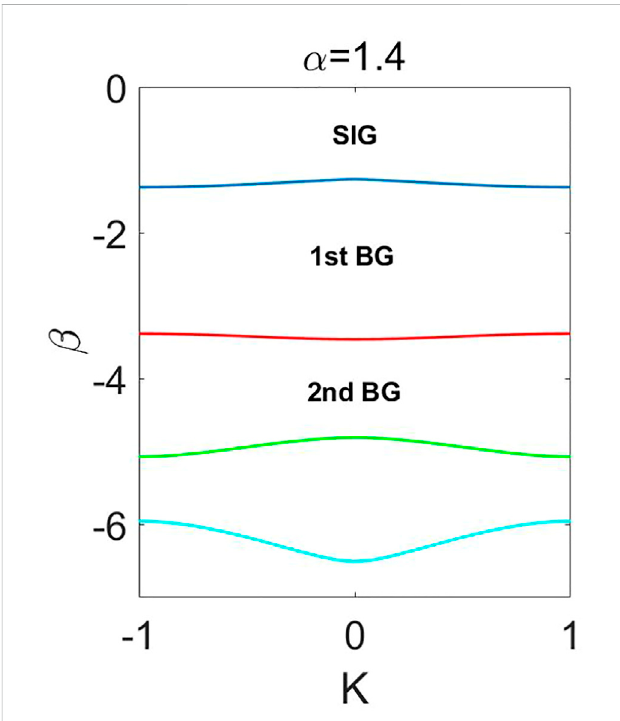
FIGURE 1 (Color online) Band-gap structure of linear spectrum β ( K ) for opticallattice V ( x ) (cid:1) V 0 sin 2 ( x ) at V 0 (cid:1) 6andLévyindex α (cid:1) 1 . 4.Regions SIG, 1st BG and 2nd BG denote, respectively, the semi-in fi nite gap, the fi rst and second band